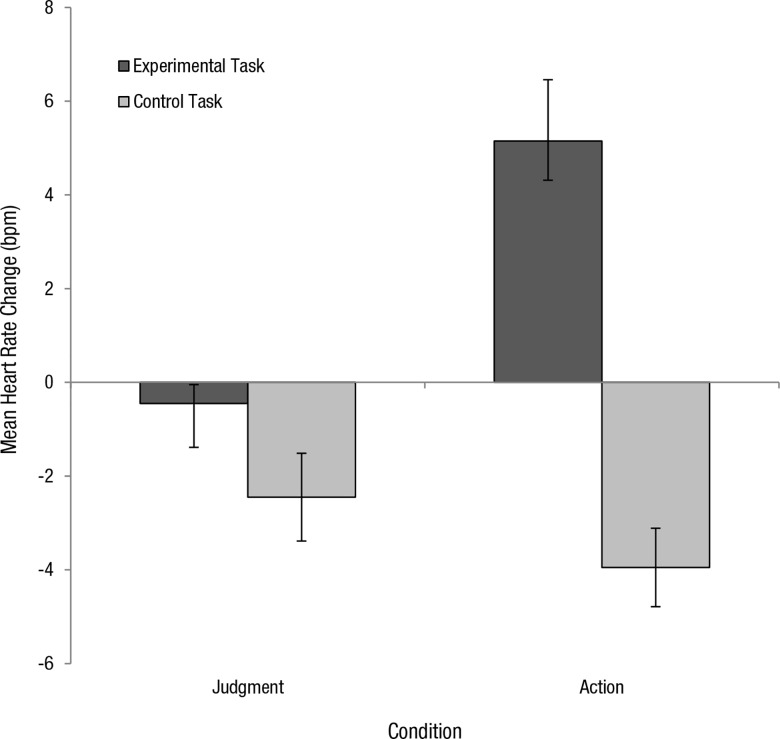
Mean heart rate change (bpm) for control and experimental tasks in both the judgment and action conditions.Increased heart rate was observed in the virtual moral dilemma. Error bars represent +- 1 SE